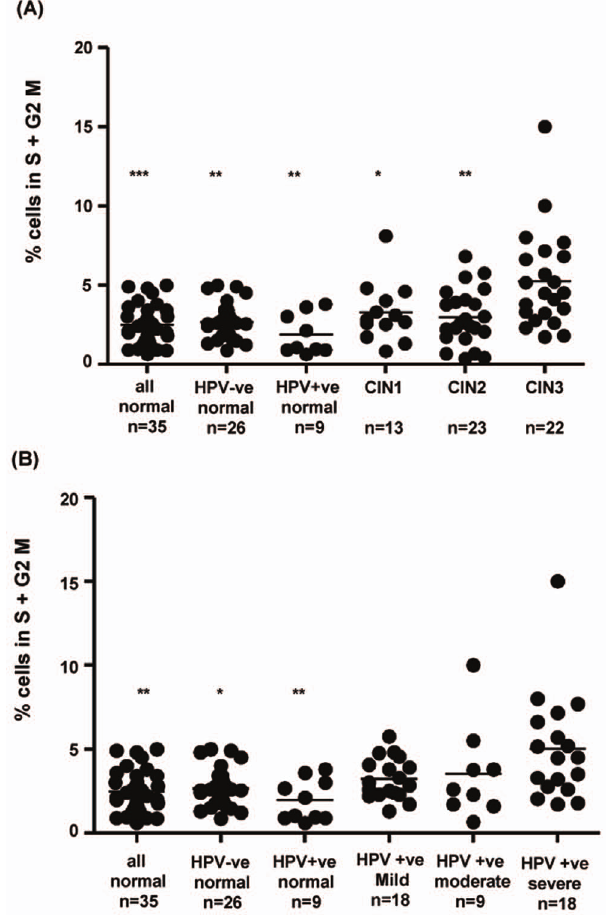
Fig. 4. Flow cytometric detection of cycling cells in cervical samples. (A) LBC samples stratified by HPV status and histology; samples from women with CIN3 are significantly different from samples with normal cytology and from CIN1 and CIN2, 1 way ANOVA (Kruskall Wallis test with Dunn’s post-test versus CIN3 group); (B) LBC samples stratified by HPV status and cytology results only; samples with severe dyskaryosis are significantly different from all normal samples 1 way ANOVA (Kruskall Wallis test with Dunn’s post-test versus severe disease group). * p 5, 0.05, ** p 5, 0.01, *** p 5, 0.001.